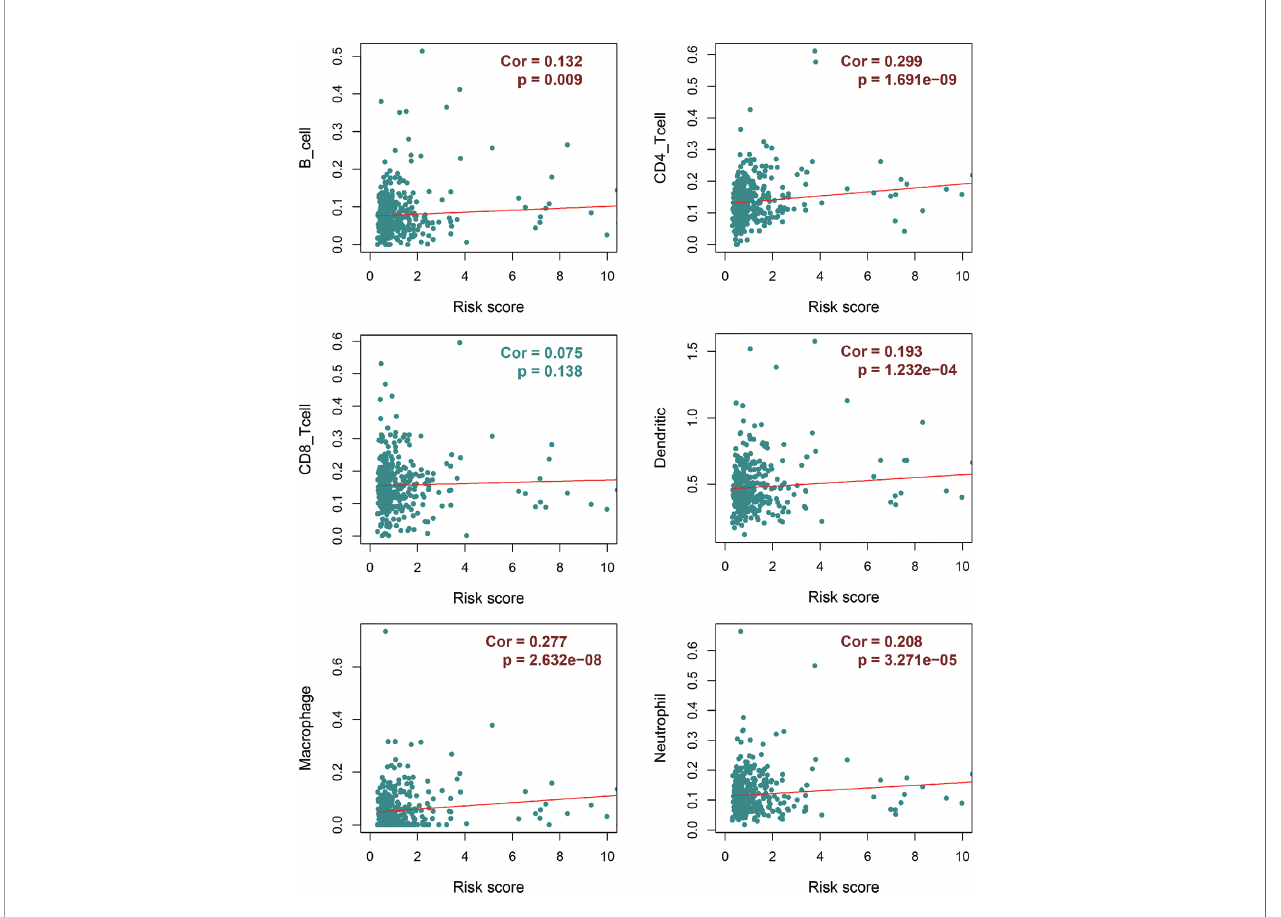
FIGURE 7 | Integrative analysis of TII risk level and six types of tumor-in fi ltrating immune